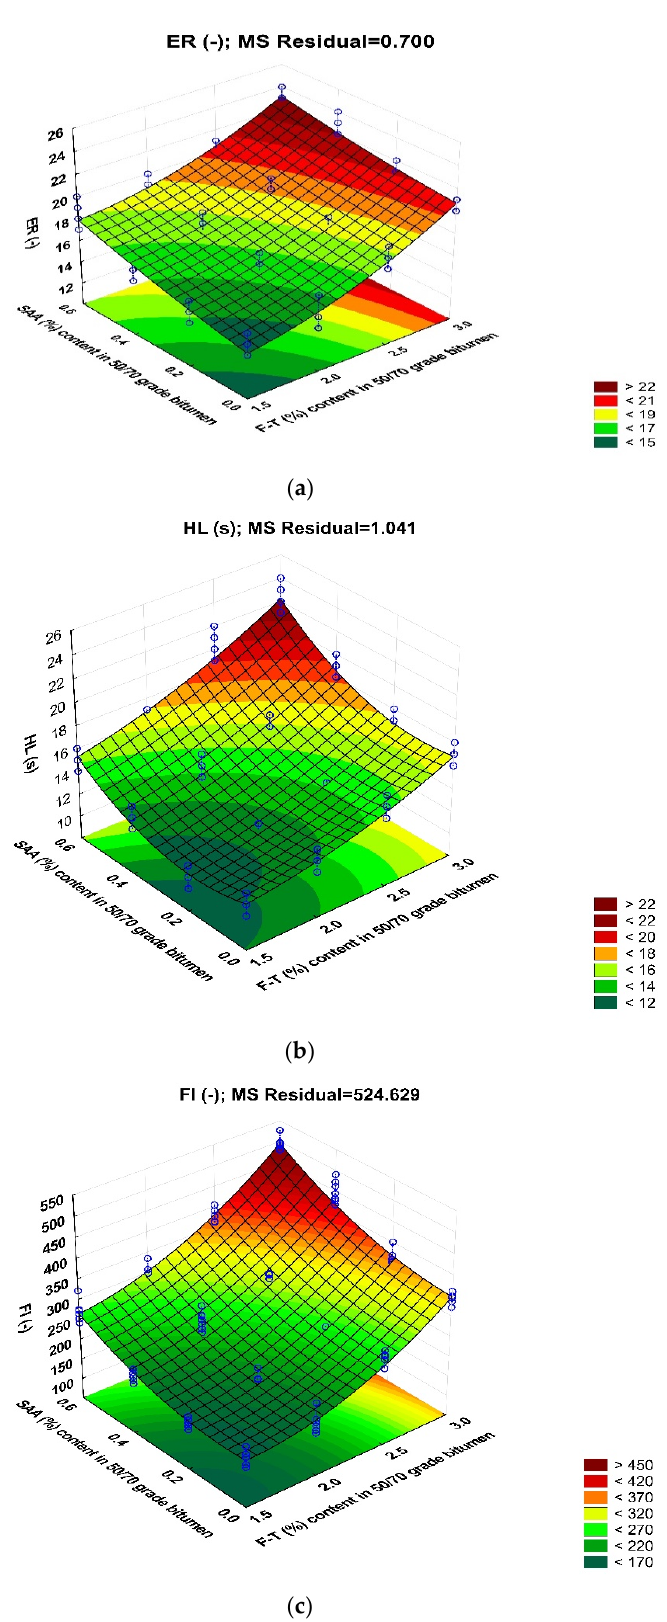
Figure 22. Relationships between bitumen 50/70 foam parameters and F–T wax and SAA contents; maximum expansion—ER ( a ), half-life—HL ( b ) and foam index—FI (c).